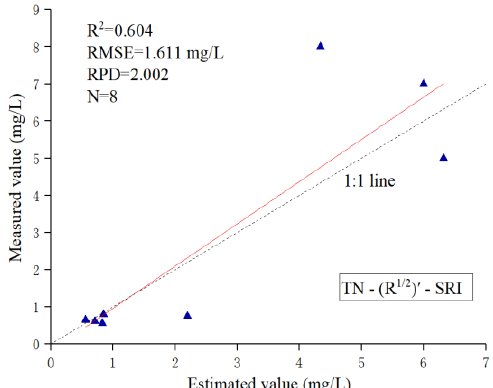
Figure 7. The best accuracy of PSO-SVM estimation model (the triangle in the figure represents the testing sample). Table 7. Estimation accuracy based on spectral transformation and spectral index coupling models. Coupling